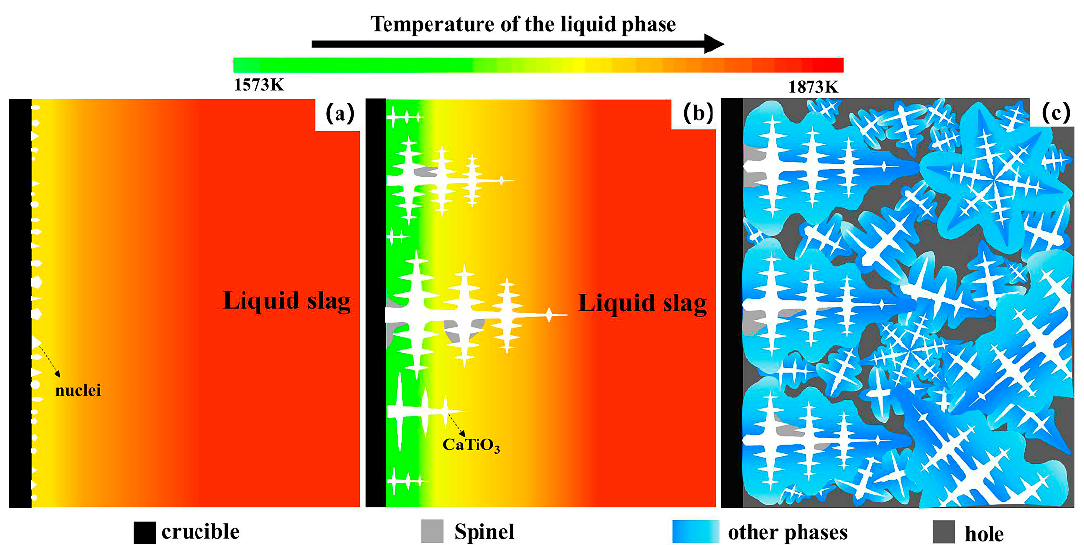
Figure 6. Schematic diagram of the ( a ) beginning of crystallization, ( b ) crystallization process, and ( c ) completion of crystallization (the change of blue depth indicates the change of titanium concentration in the phase.).